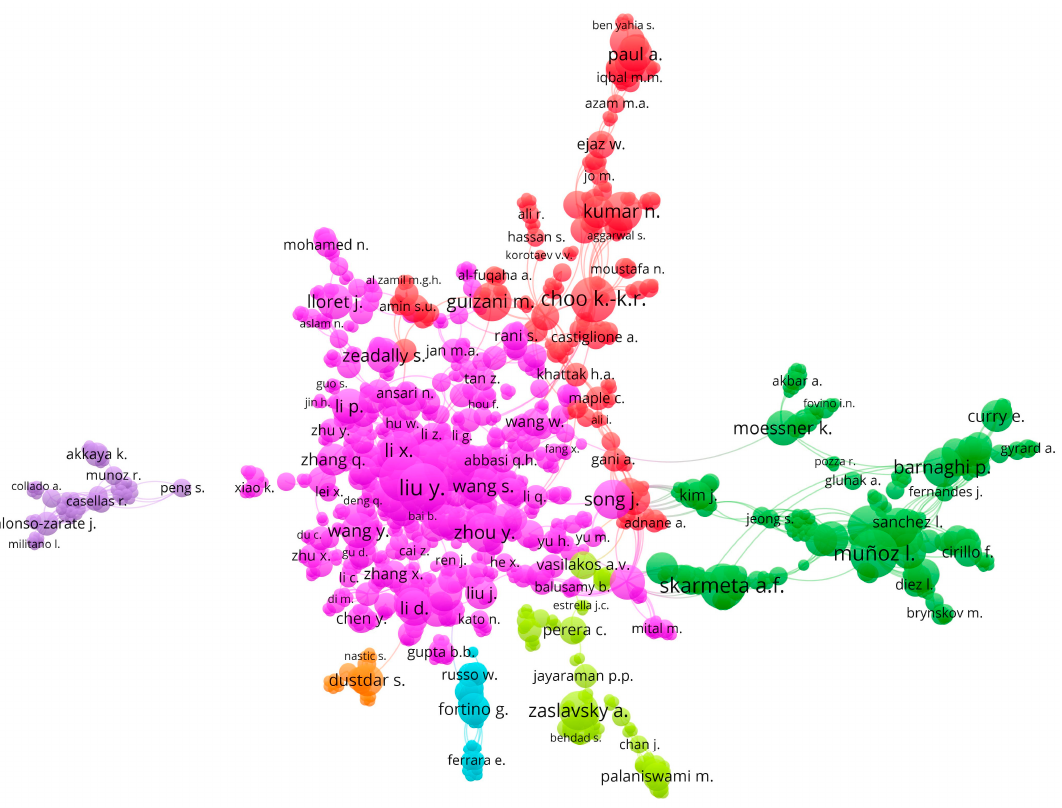
Figure 5. Authors network based on co-authorship method (2011–2019).